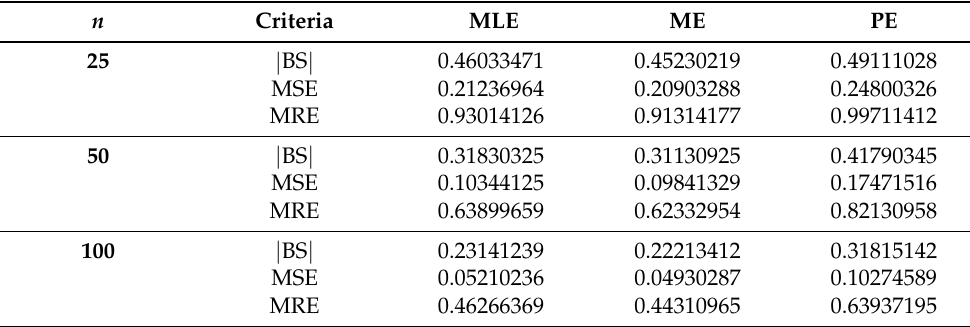
Figure 5. Simulation visualization plots for β = 0.15. Table 4. Simulation results for β =